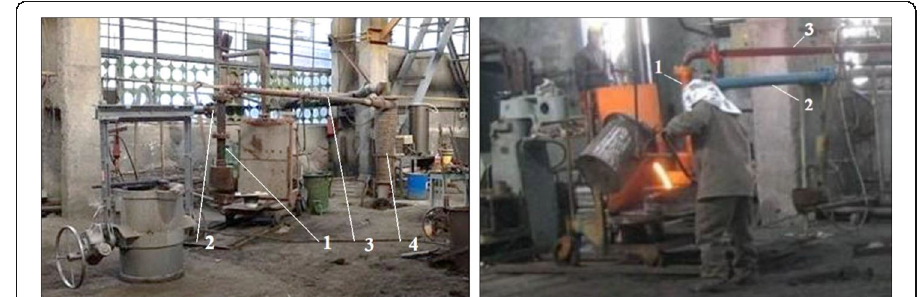
Fig. 2 Plant for hydro-vacuum granulation of melts. 1 — hydro-vacuum exhaust and dispersion unit; 2 — high-pressure water supply system; 3 — pulp disposal hydrosystem; 4 — electromagnetic cyclone for catching separated metallic